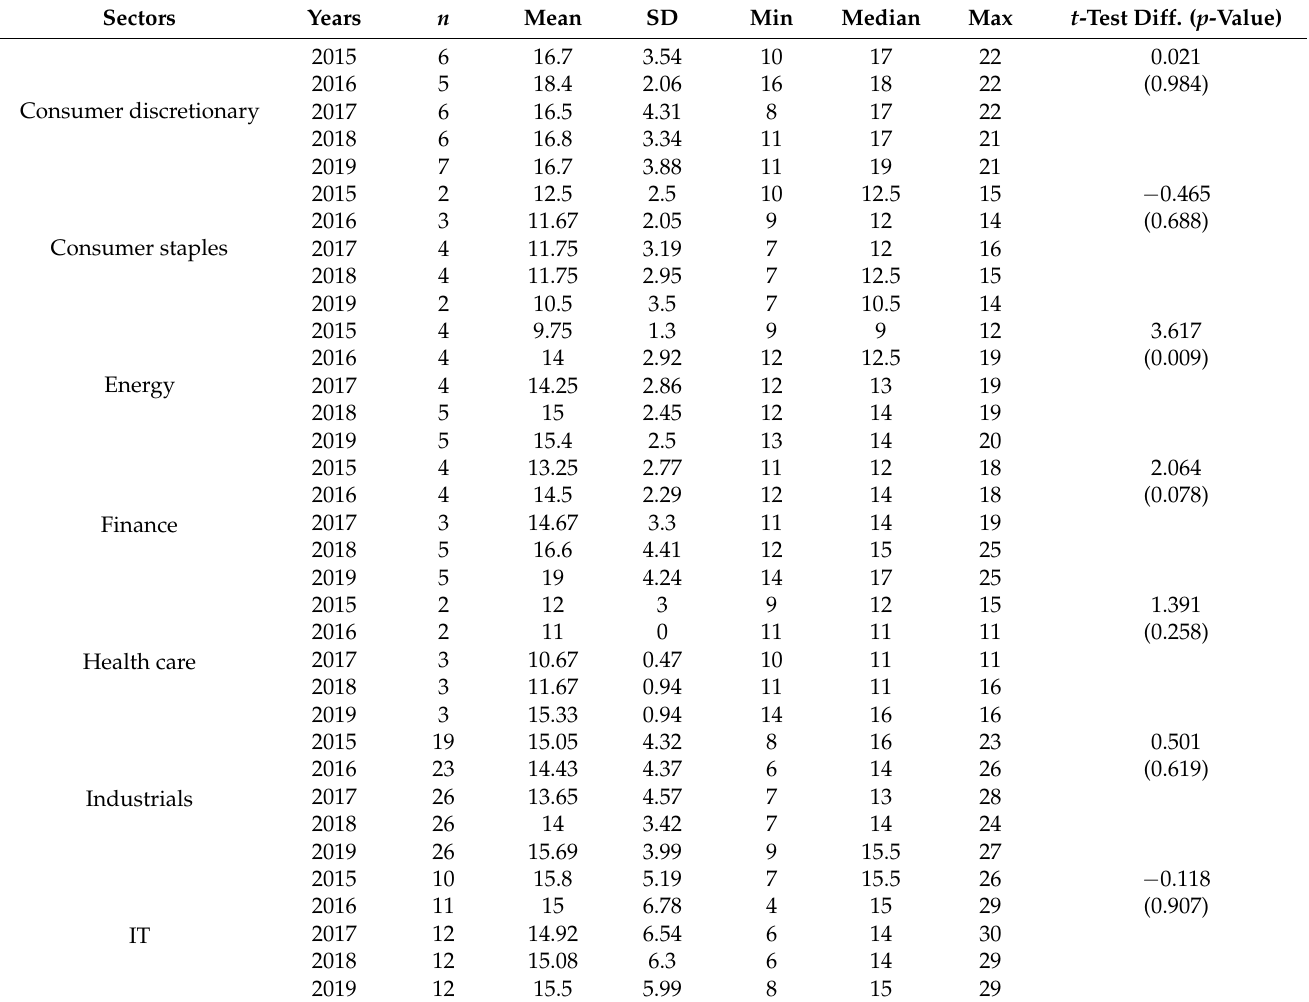
Table A1. Comparison between Different